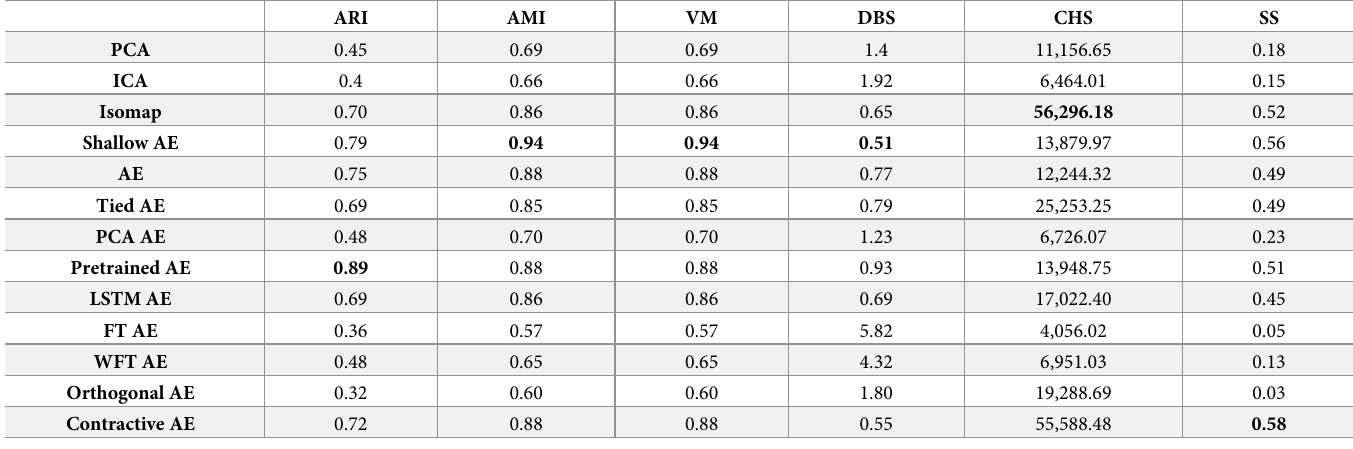
Table 8. Comparison of different Autoencoder variations vs state-of-the-art methods on Sim35 (13 clusters), the optimal value of neighbours for Isomap was found as 20 through grid search. The metrics indicate that several variations of autoencoders and the Isomap algorithm are able to outperform conventional algorithms such as PCA or ICA for the Sim35 dataset that contains a moderate number of clusters. Moreover, the Shallow AE variant outperforms Isomap with regard to the all metrics but CHS, the values indicating the highest performance for each metric have been bolded.